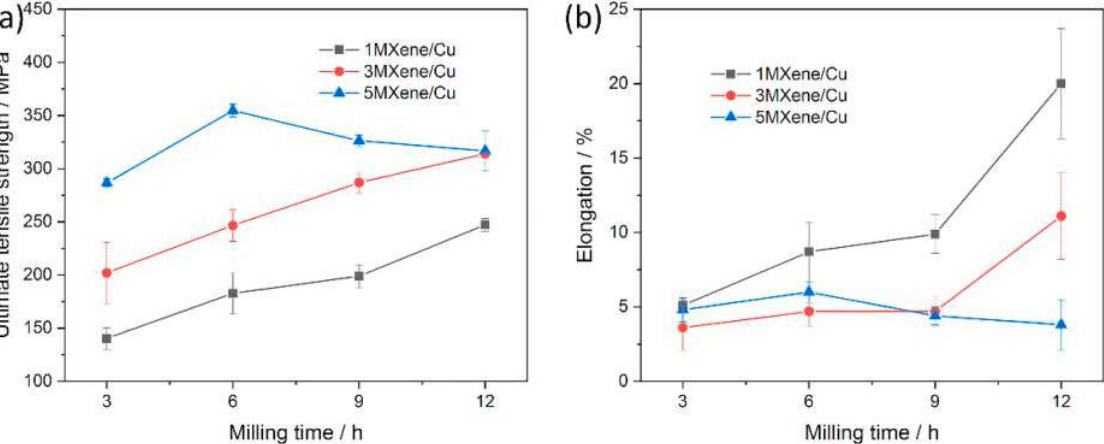
Figure 33. ( a ) The variation of the UTS as a function of milling time for the MXene/Cu composites with various MXene content. ( b ) The variation of the elongation as a function of milling time for the MXene/Cu composites with various MXene content [74].